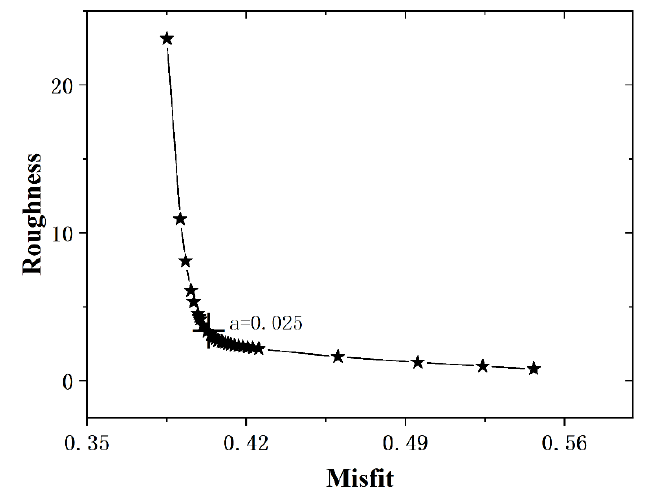
Figure 6. Smoothing factor determination graph (indicated by letter a).